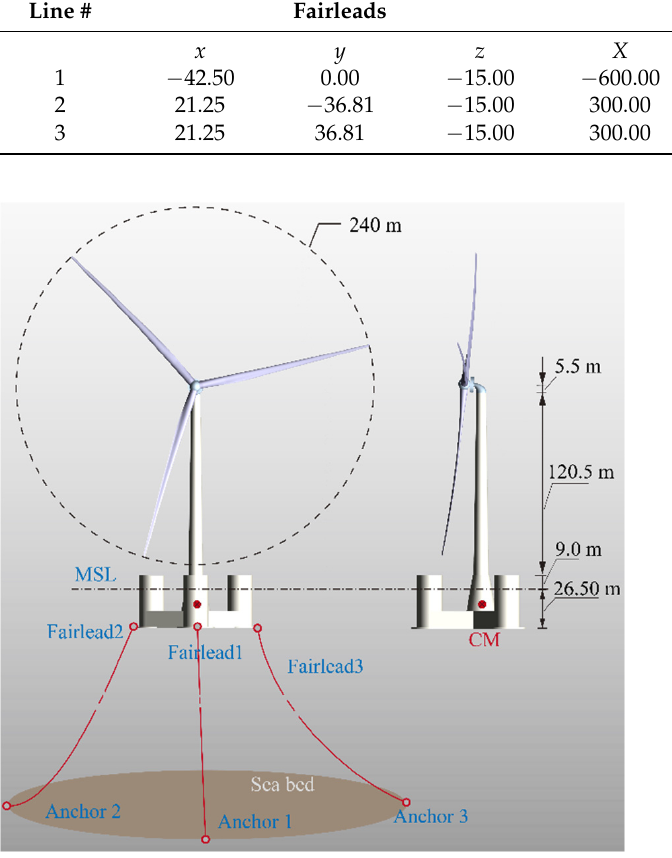
Figure 3. Schematic diagram of the IEA 15 MW wind turbine on the ActiveFloat platform.